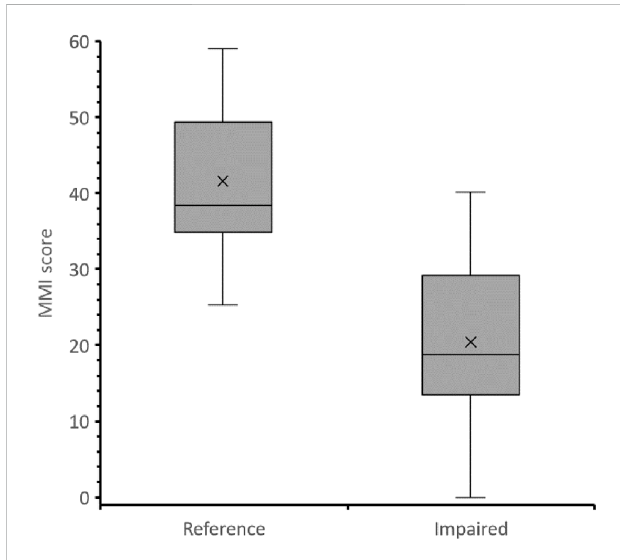
FIGURE 4 Box-Whisker plot of multi-metric index scores of reference and impaired wetland